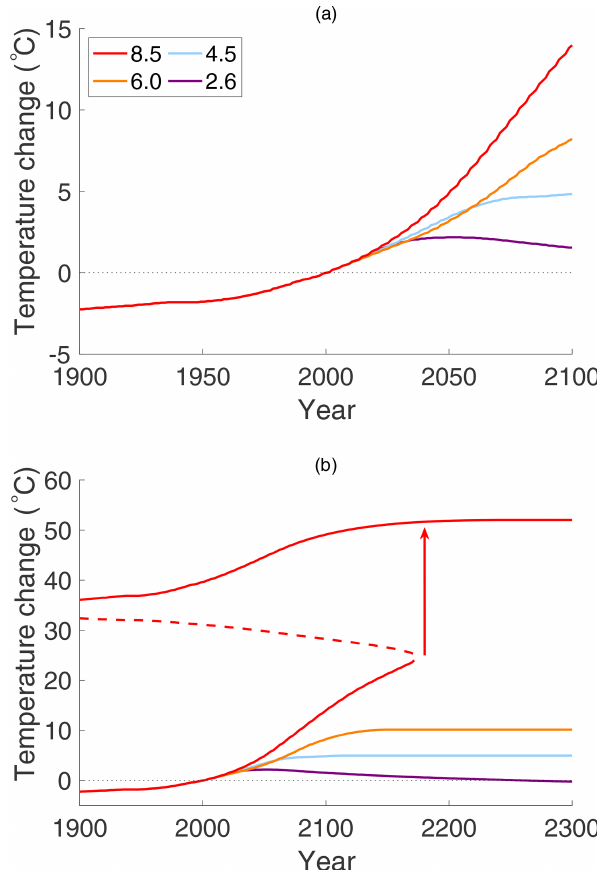
Figure 6. Arctic surface temperature change, relative to the year 2000 average temperature of − 28 . 90 ◦ C, for each of the four RCPs with constant F O = 10Wm − 2 and with δ = 0 . 6. In (a) , the EBM temperature change is projected to year 2100, and in (b) it is pro- jected to year 2300, following the assumptions of the RCP pathways in Fig. 4. Note the dramatic jump in temperature on RCP 8.5, result- ing from a saddle-node bifurcation, predicted near the year 2170. The vertical arrow is not an actual trajectory of the dynamical sys- tem but rather represents the transition to a new equilibrium state that occurs after the disappearance of the saddle